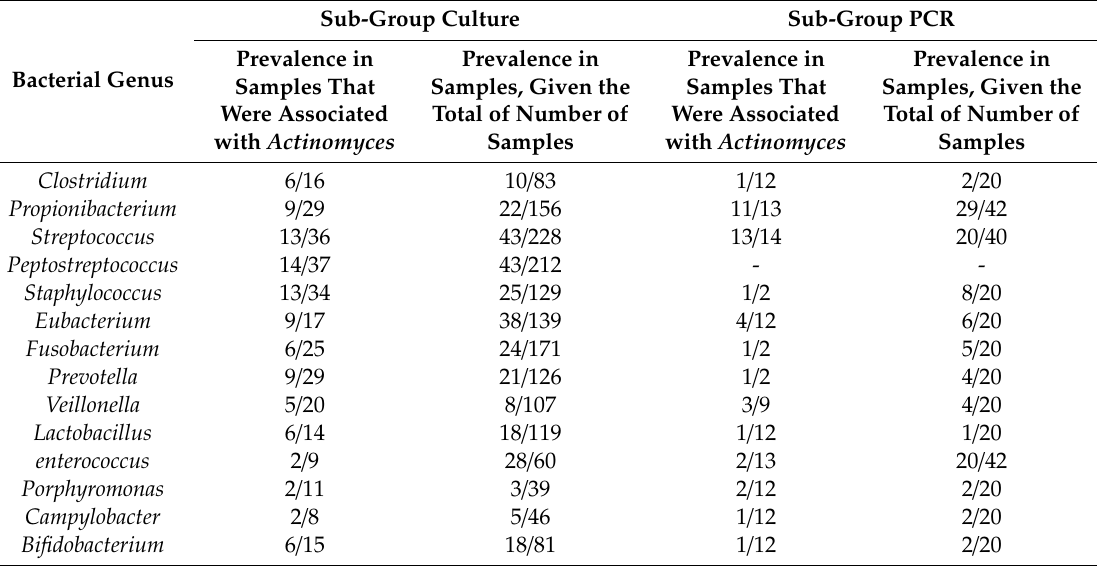
Table 5. Data referring to the two sub-groups (culture and PCR).